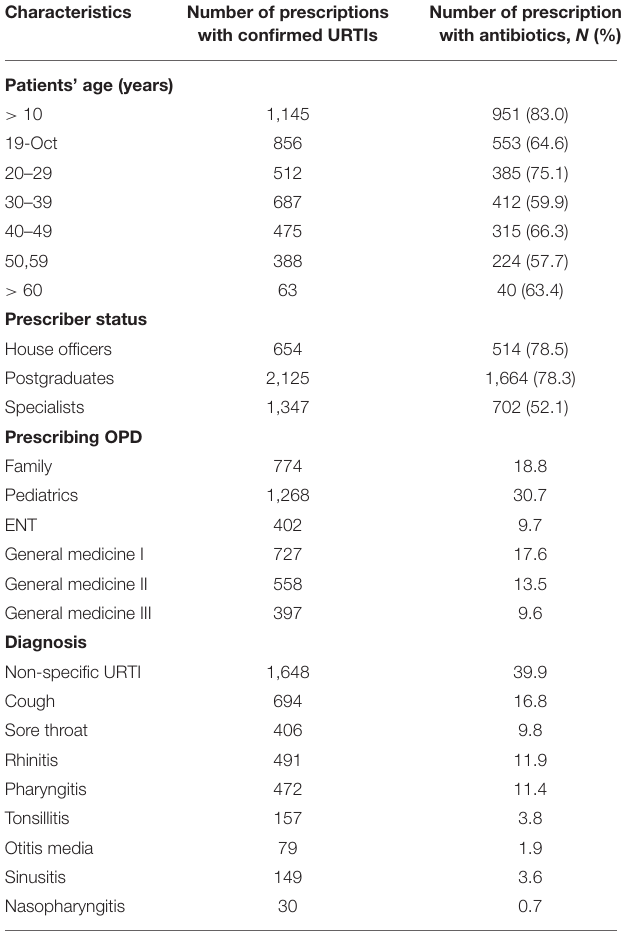
TABLE 1 | Study characteristics by age, prescriber status, and diagnosis.